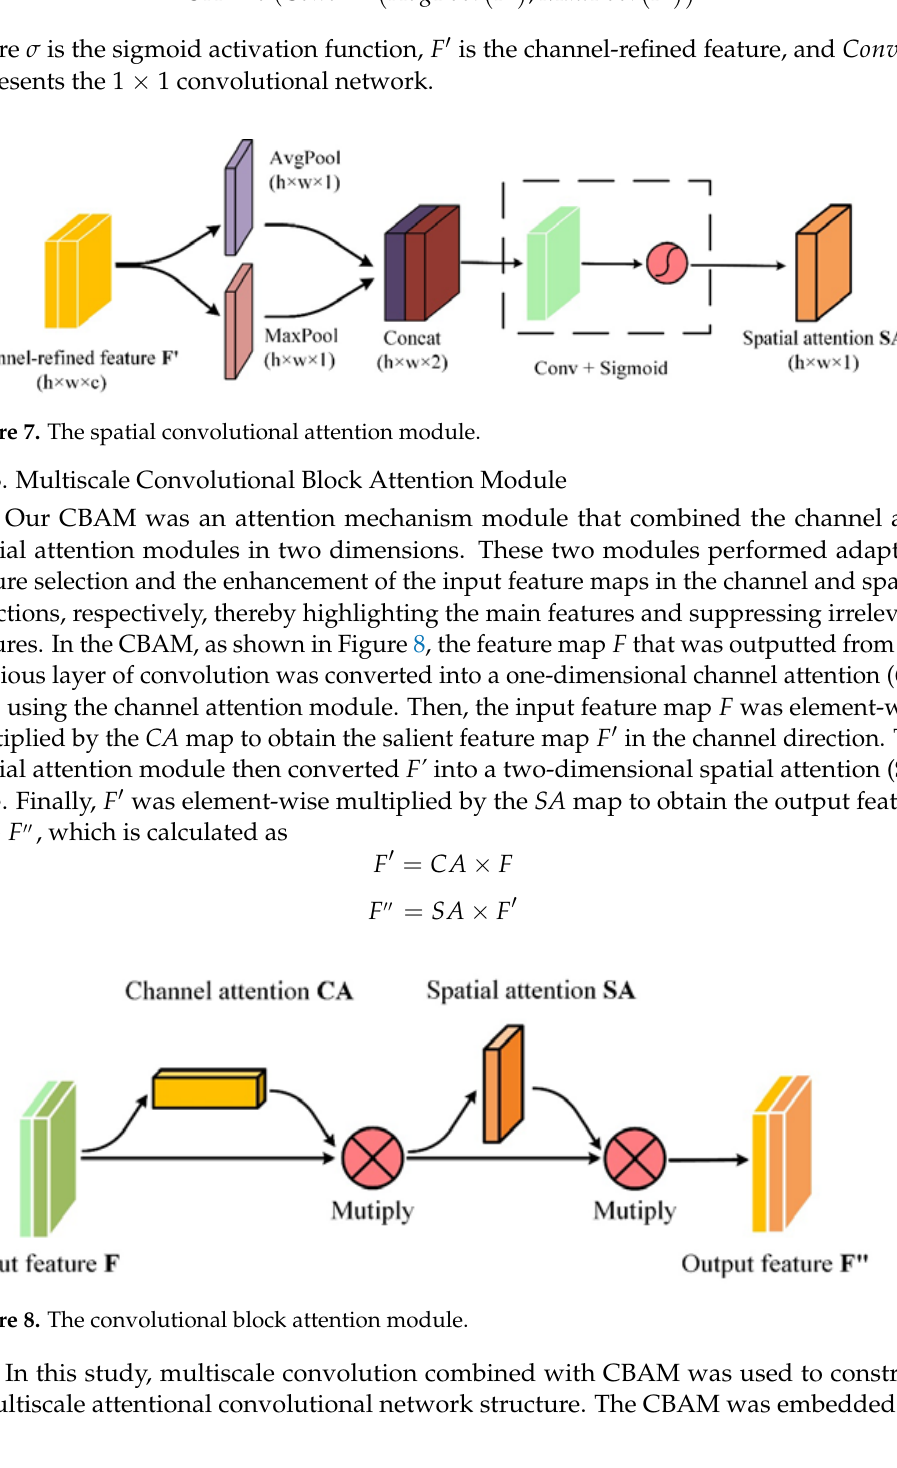
Figure 6. The channel convolutional attention module.